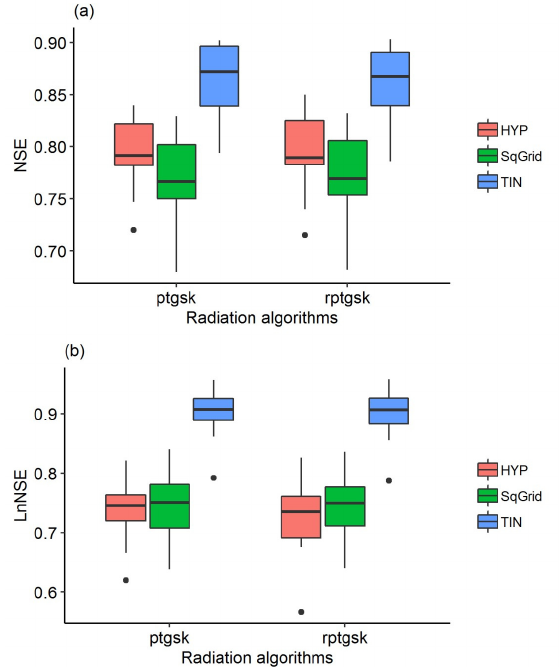
Figure 7. Model efficiency during the high-flow ( a ) and low-flow ( b ) conditions under three catchment discretization types, i.e., elevation bands (HYP), square grids (SqGrid), and TIN as well as under two radiation algorithms (with (RPTGSK) and without (PTGSK) corrections based on certain terrain